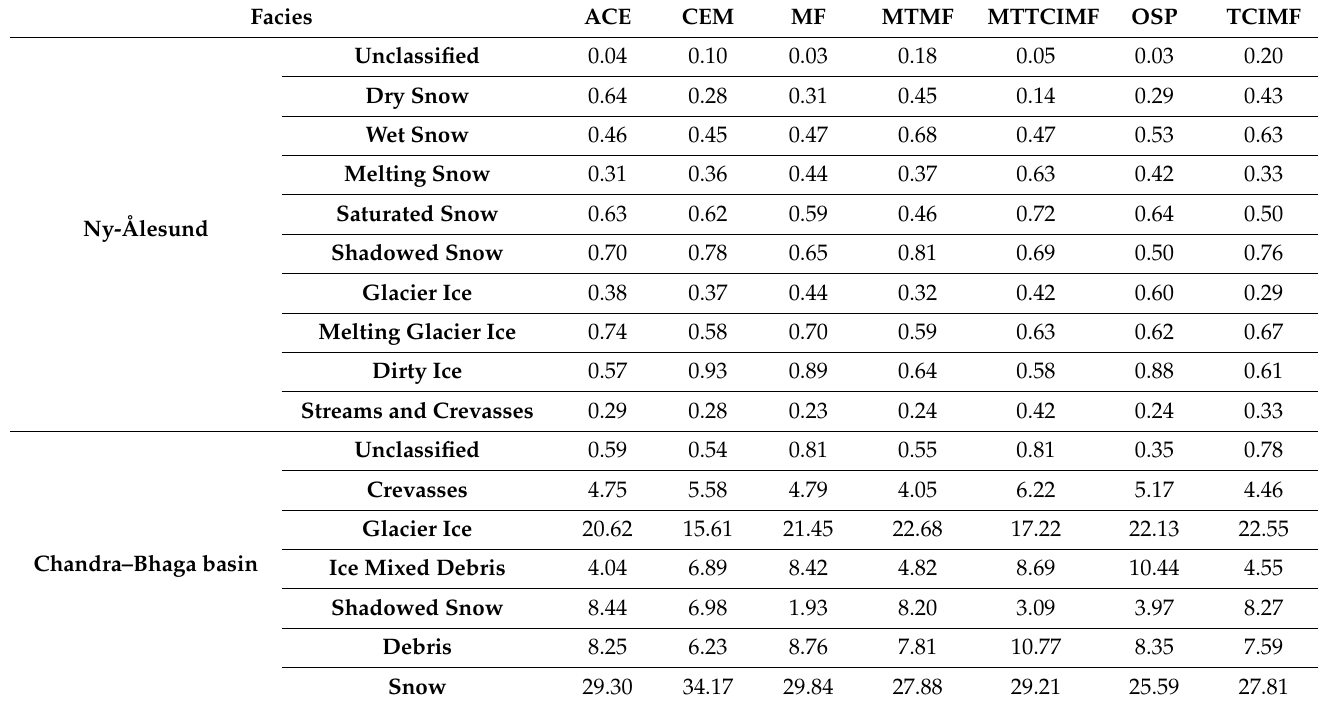
Table 7. Classified area of each facies as an average of the results for all AC classification algorithms for each processing